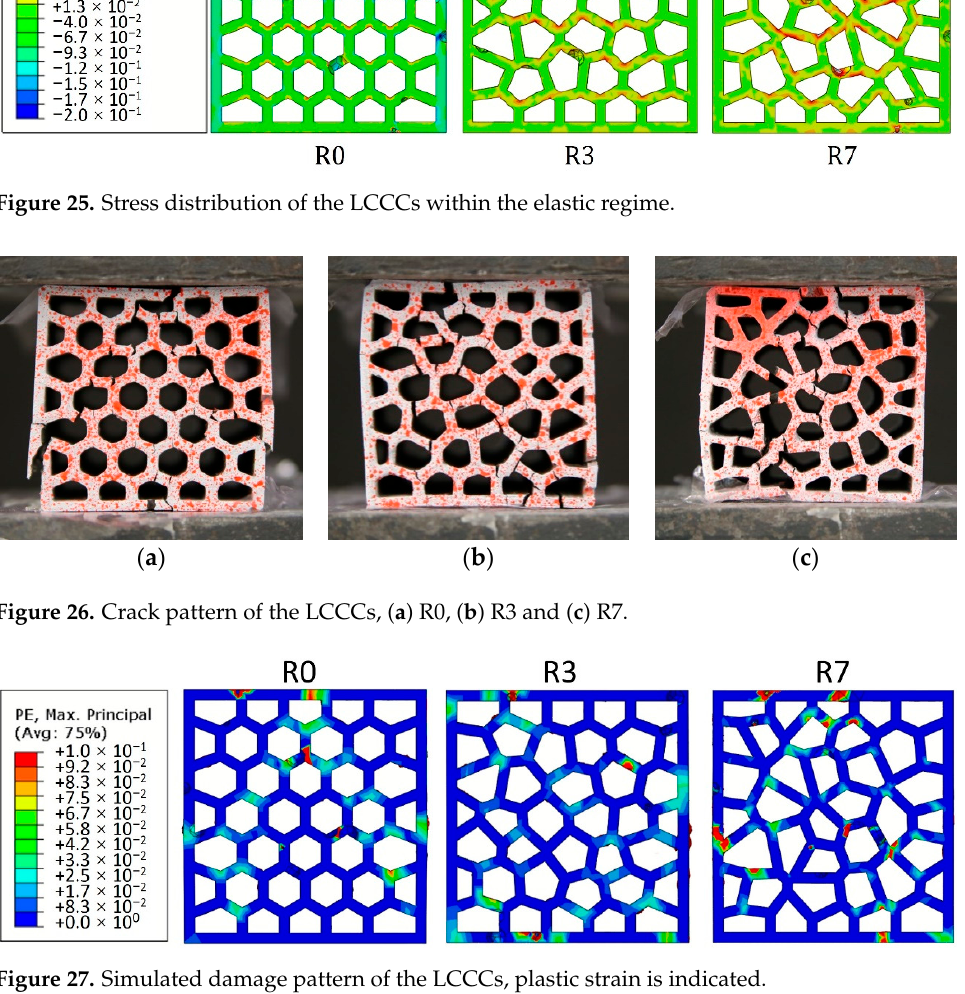
( b ) Figure 28. In-plane stress–strain curves of ( a ) R7-REF and ( b ) R7-PCM14; note that the y-axes of the two figures are differ- ent.